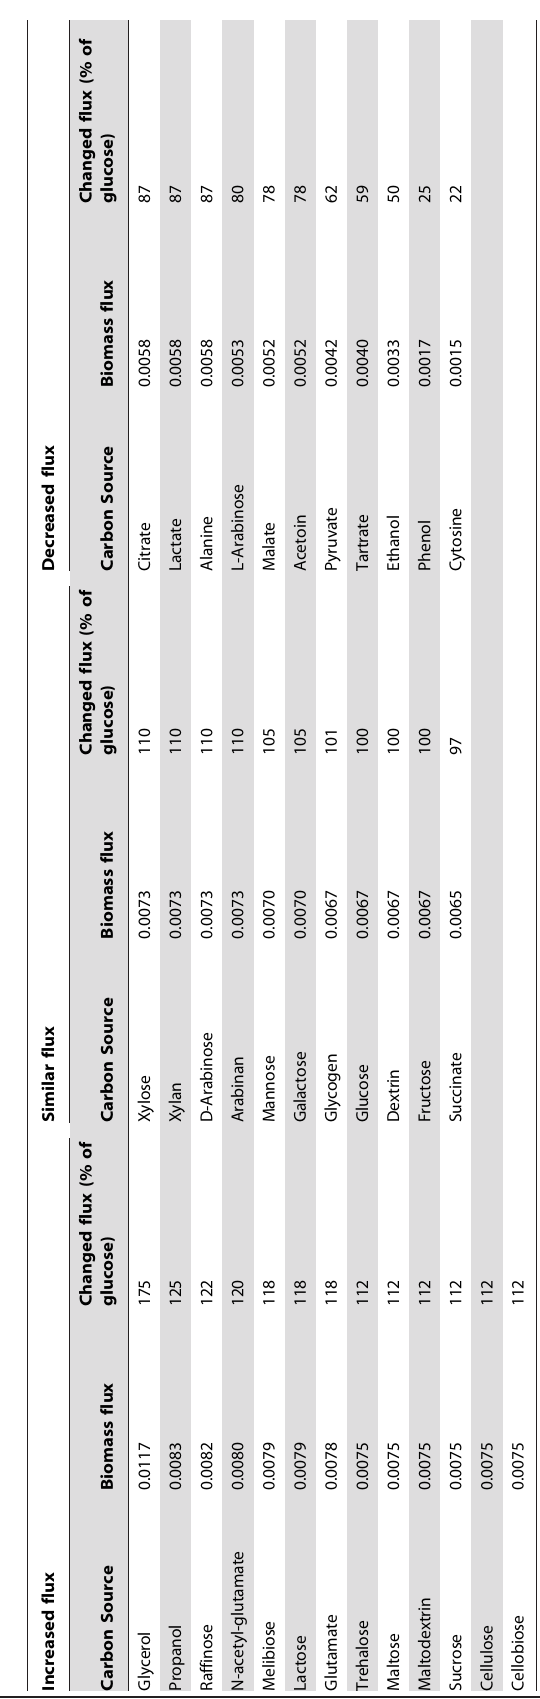
hydratase (Figure 2: (8)) are predicted to be lethal. All of these are the TCA cycle and cannot be bypassed by other reactions.